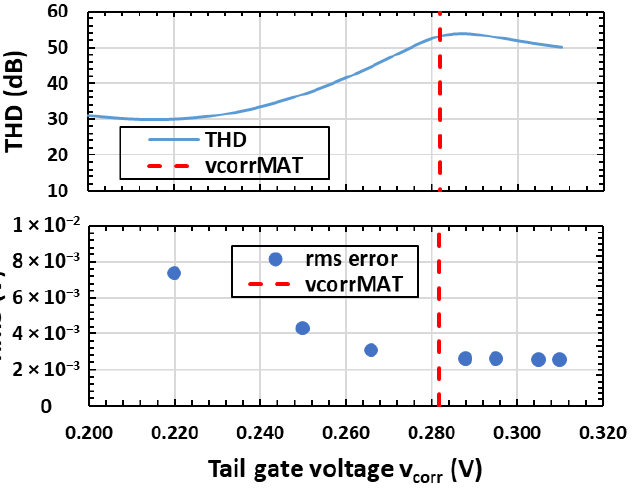
Figure 10. THD of the track-and-hold circuit ( top ) and RMS error given by non-linearities for PRBS input signal ( bottom ) in typical PVT condition.